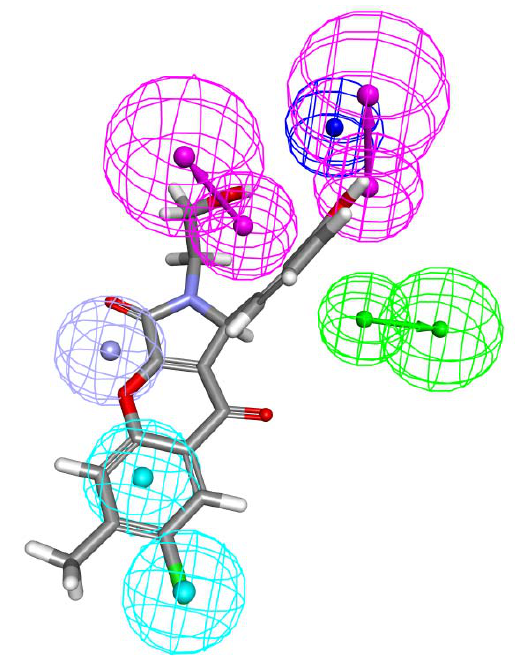
Figure 8. Zinc02230638 mapped over the generated structure-based